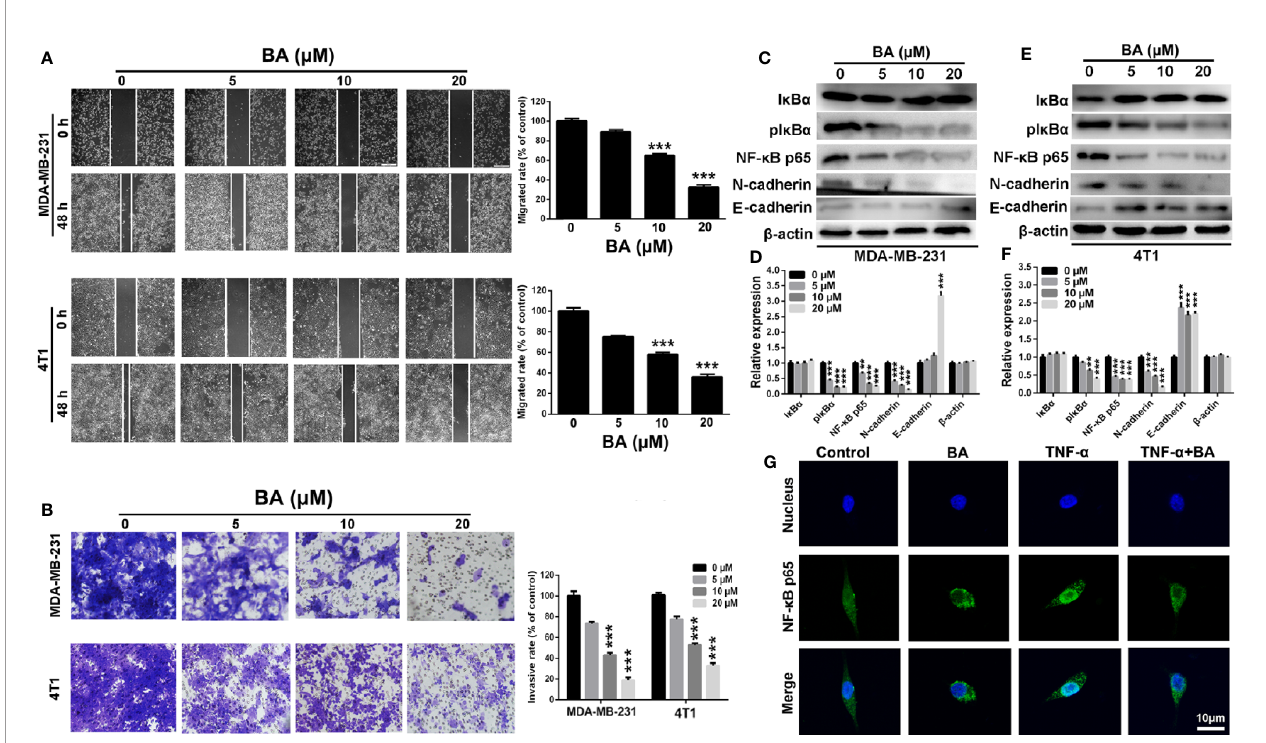
FIGURE 3 | BA inhibited breast cancer migration and invasion via NF- k B signaling pathway. (A) Migrations of MDA-MB-231 and 4T1 cells were measured by wound-healing assay after treated with different concentrations (0, 5, 10, and 20 m M) of BA for 48 h. (B) Invasions of MDA-MB-231 and 4T1 cells were examined by transwell assay after different concentrations (0, 5, 10, and 20 m M) of BA for 48 h. (C – F) Changes of NF- k B and EMT related proteins in MDA-MB-231 and 4T1 cells were evaluated by western-blot assay after different concentrations (0, 5, 10, and 20 m M) of BA for 48 h. (G) Immuno fl uorescent analysis of nuclear transportation of NF- k B p65 protein in HCT116 cell. Cells were exposed to 20 m M of BA for 24 h and/or 15 ng/ml of TNF- a for 4 h. Signi fi cant differences are indicated as follows: ** P < 0.01; *** P <